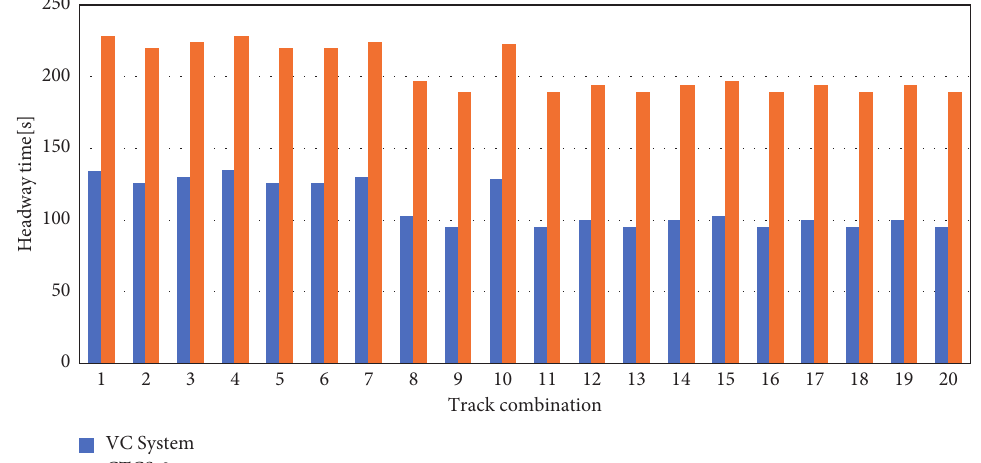
Figure 12: Outcomes of train headways for scenario